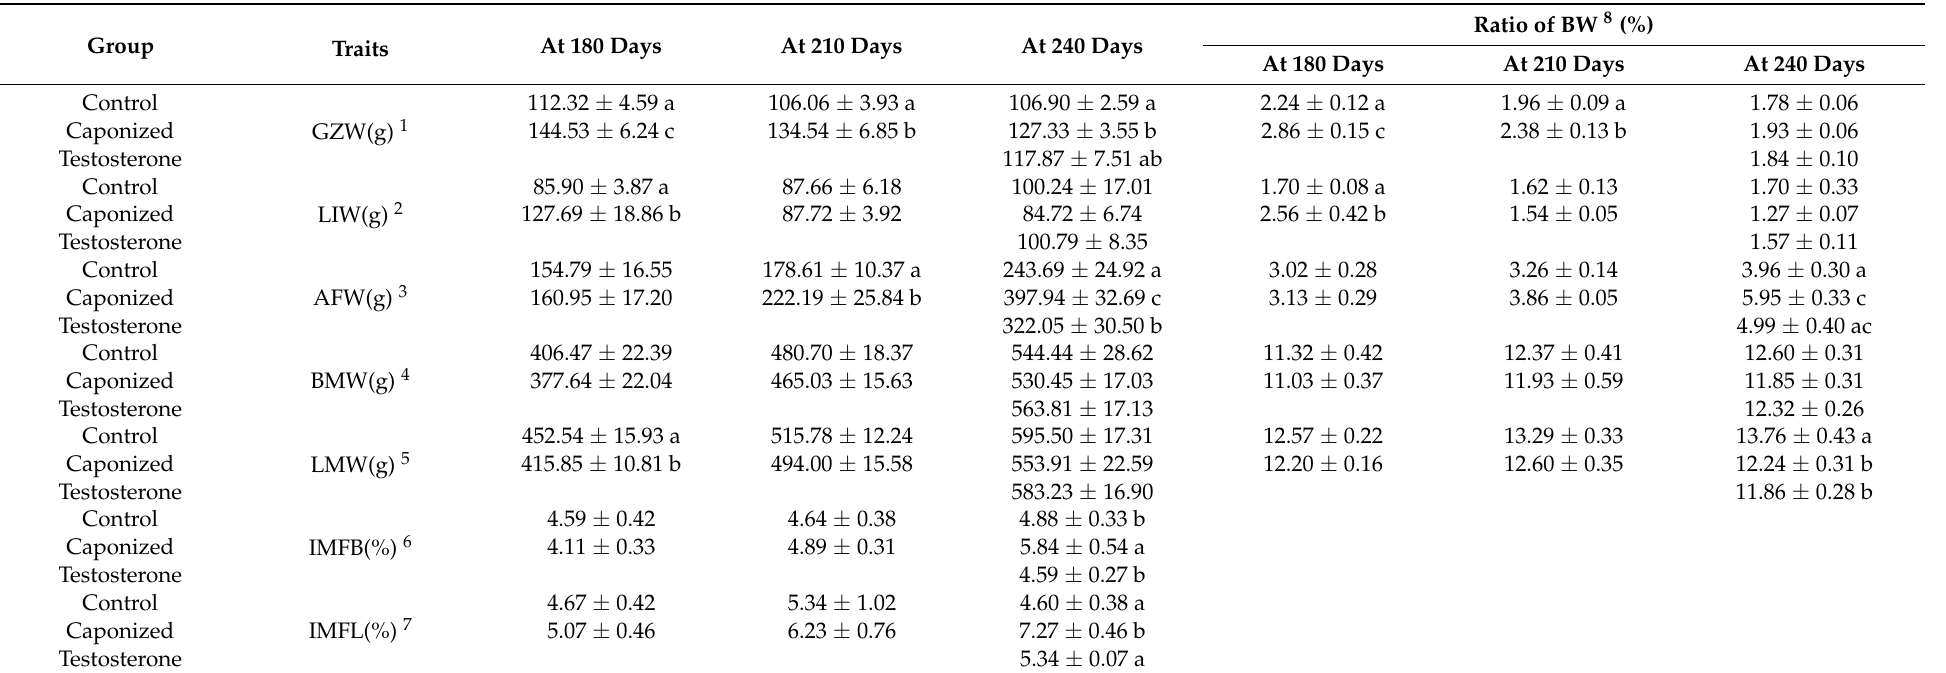
Table 1. Carcass traits in the control group, the caponized group, and the testosterone group at 180 days, 210 days, and 240